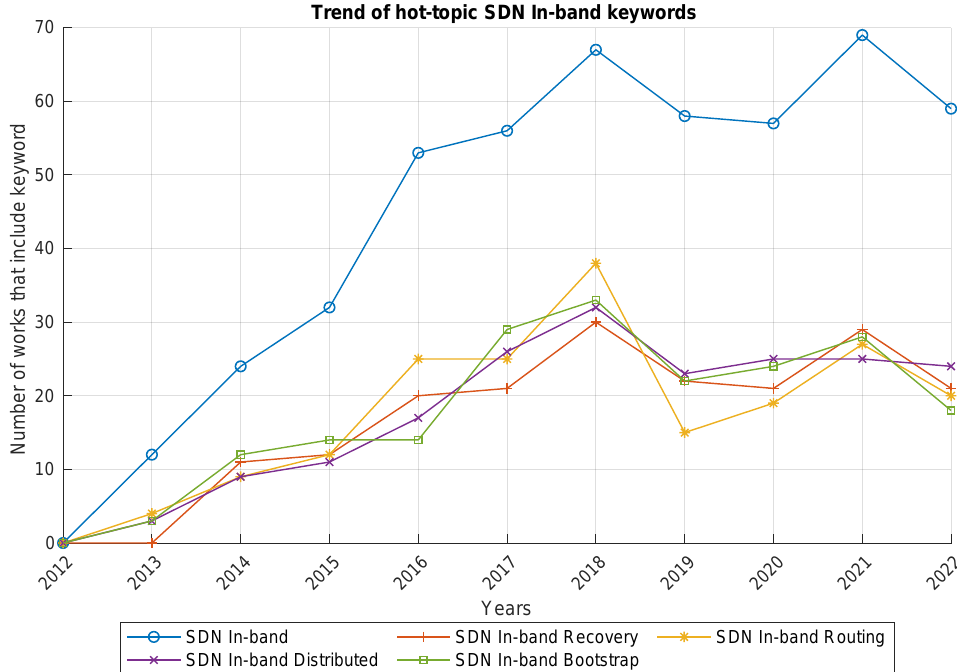
Figure 3. Trend of published articles related to SDN